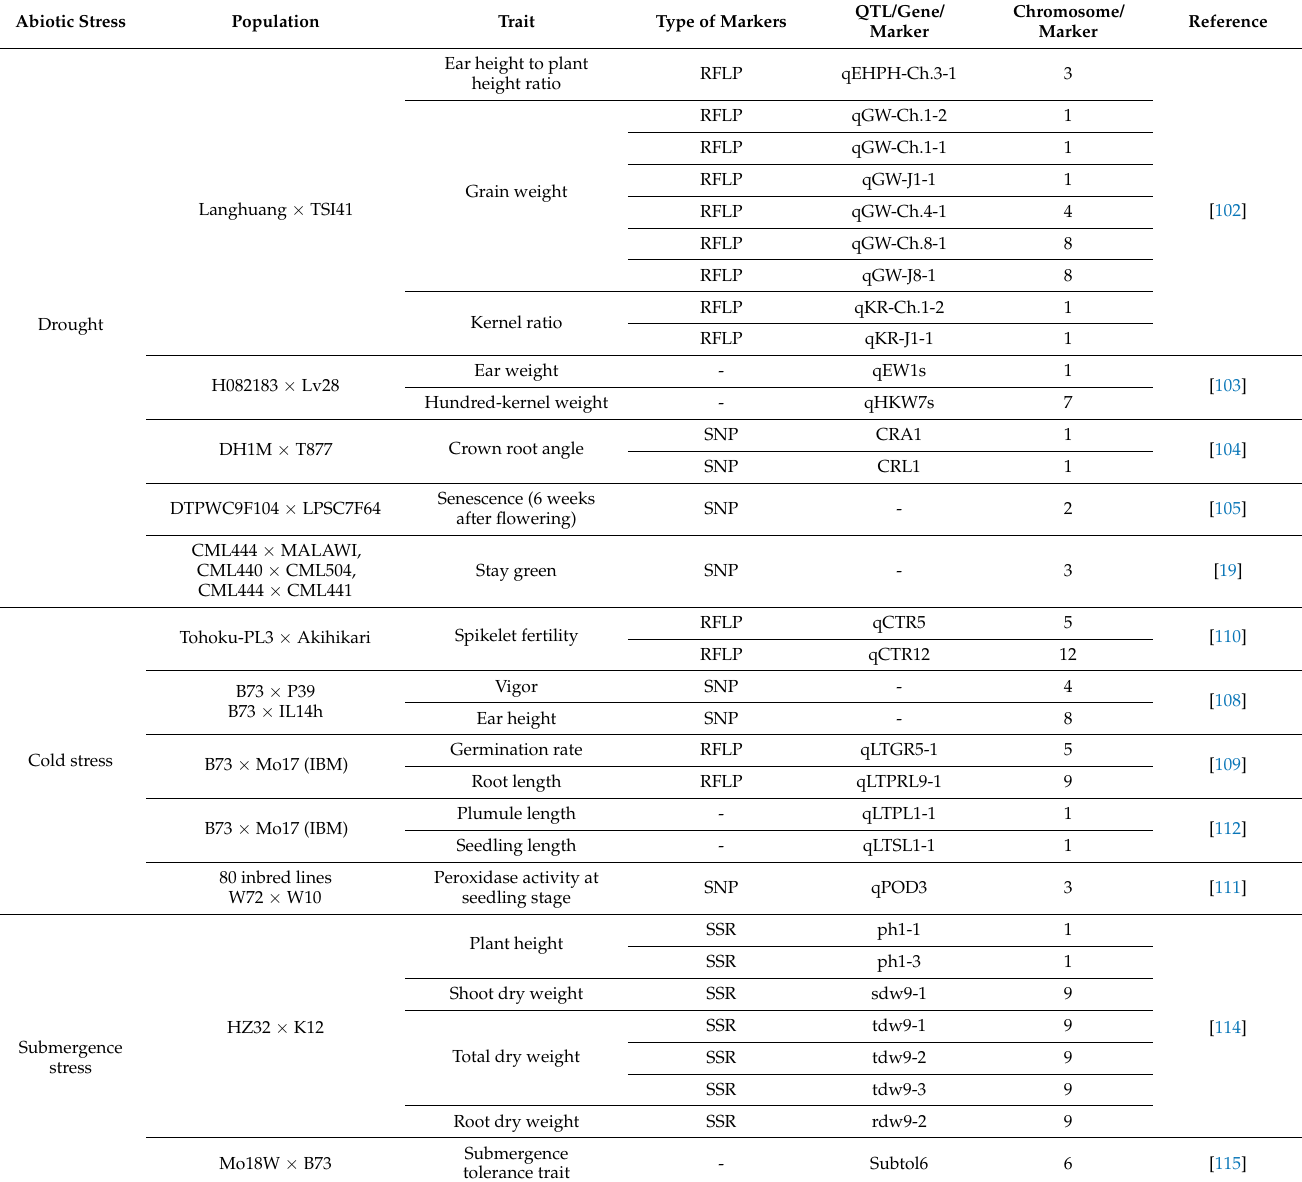
Table 2. List of QTL linked to abiotic stress tolerance in